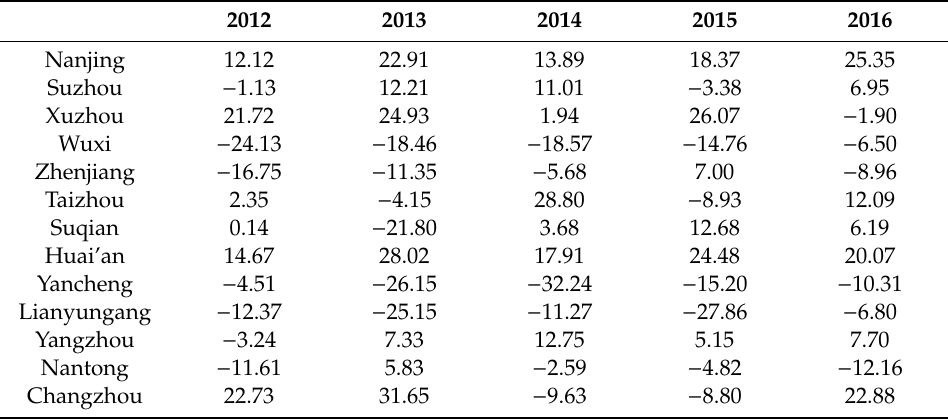
Table 5. Urban ecological civilization score based on Incidence Matrix.